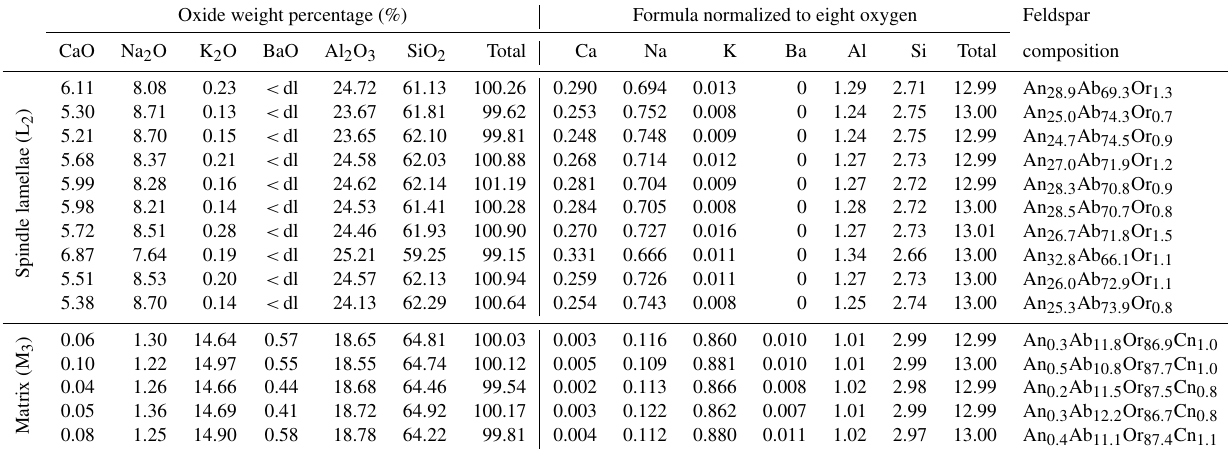
Table 2. EPMA results of the spindle lamellae (L 2 ) and the orthoclase matrix (M 3 ), following the notation of Evangelakakis et al. (1993). Oxide weight percentage